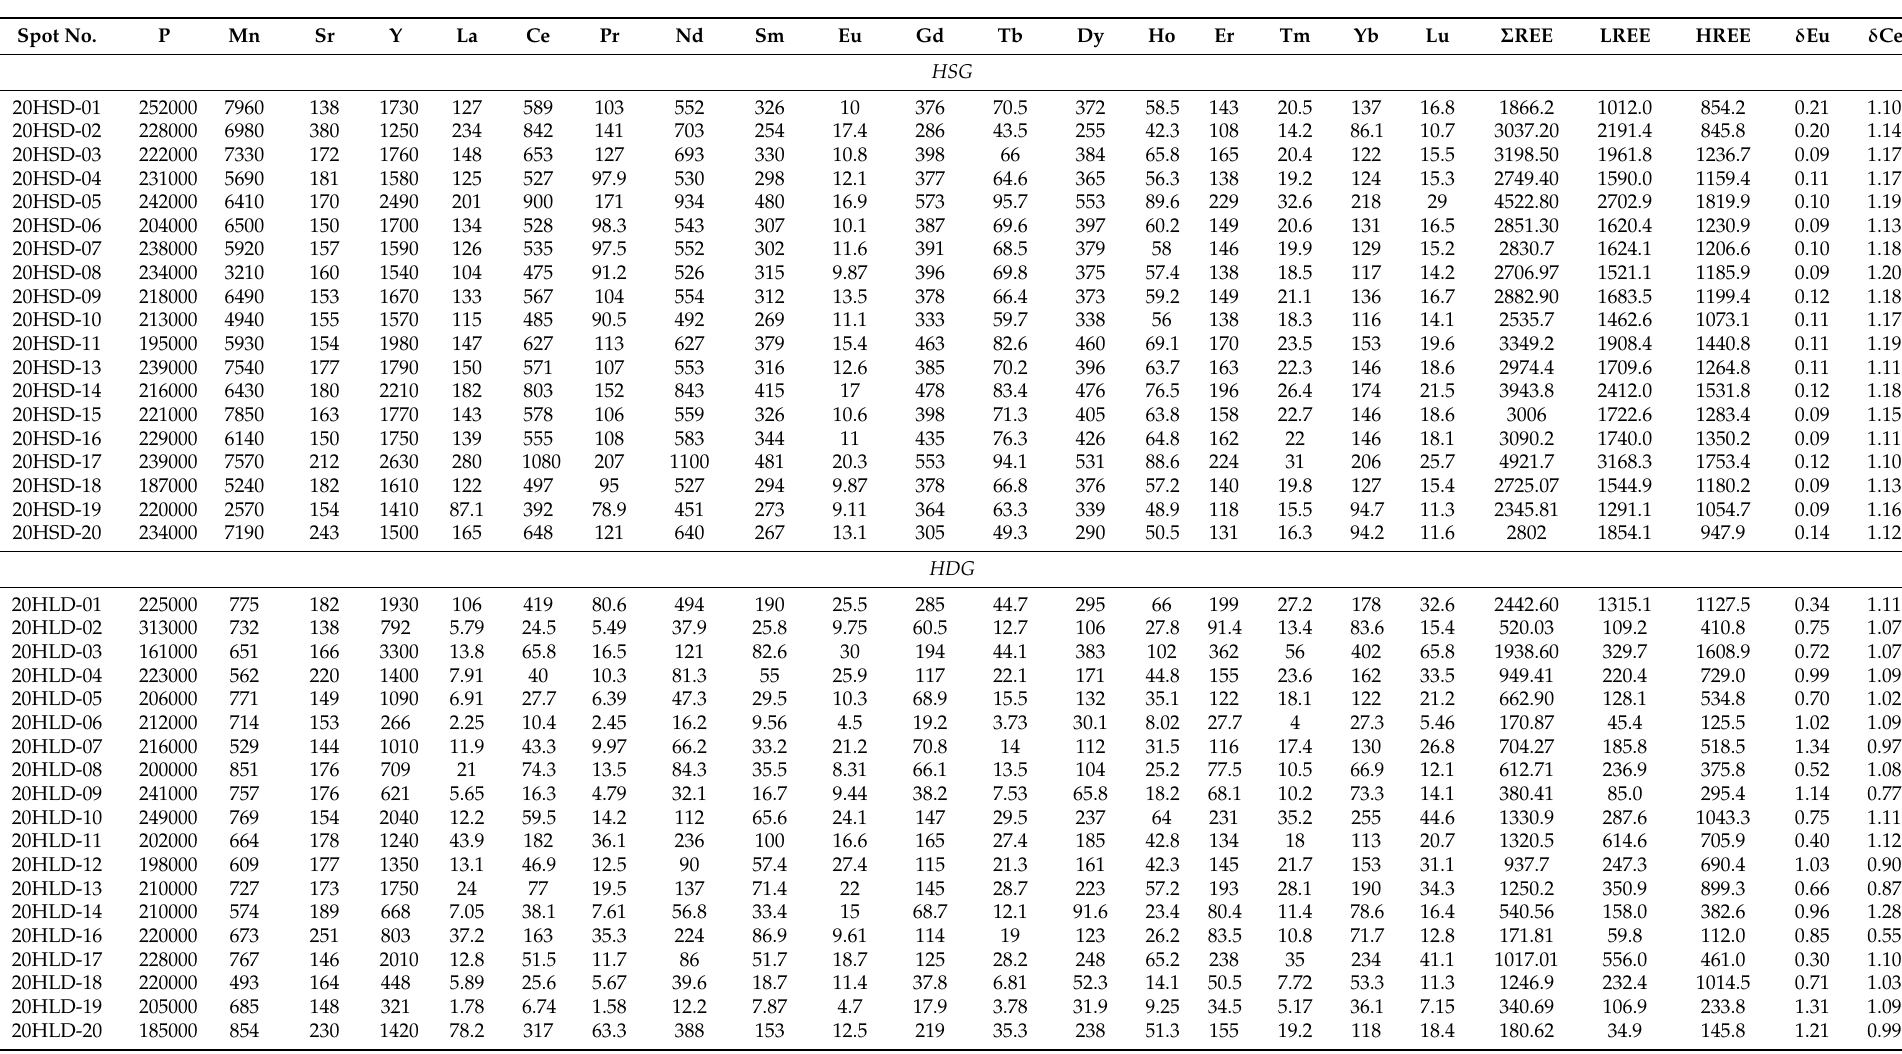
Table 5. Trace element compositions (10 − 6 ) of apatite grains from the HSG and HDG of the KDSZ. Spot